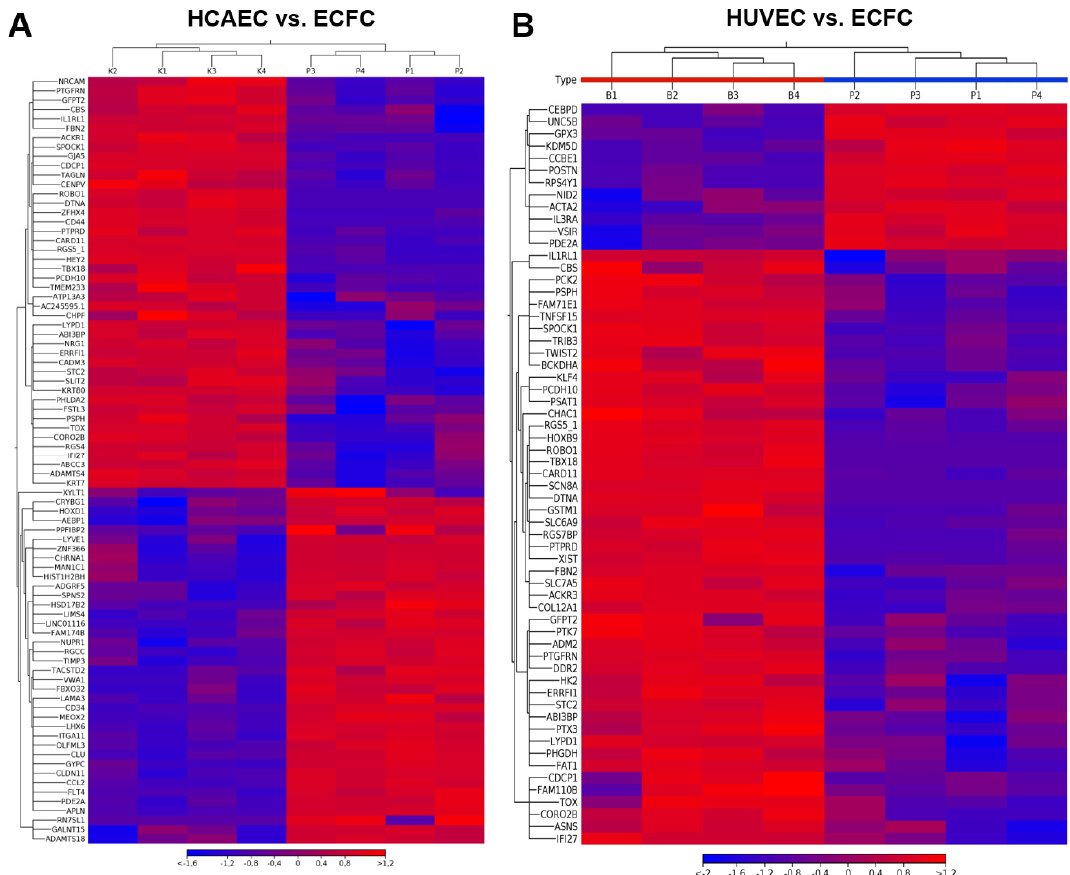
Figure 3. Heatmaps of di ff erentially expressed genes between ( A ) human coronary artery endothelial cells (HCAEC) vs. ECFC (only those having fold change 0.1 ( − 10) or 10, respectively, and FDR p -value < 0.05 are represented in the heatmap); ( B ) HUVEC vs. ECFC (only those having fold change 0.2 ( − 5) or 5, respectively, and FDR p -value < 0.05 are represented in the heatmap). Top panel: dendrogram showing the results of hierarchical sample clustering. Left panel: Dendrogram showing the results of hierarchical di ff erentially expressed genes (DEGs) clustering. DEGs labeling based on Ensembl annotation.